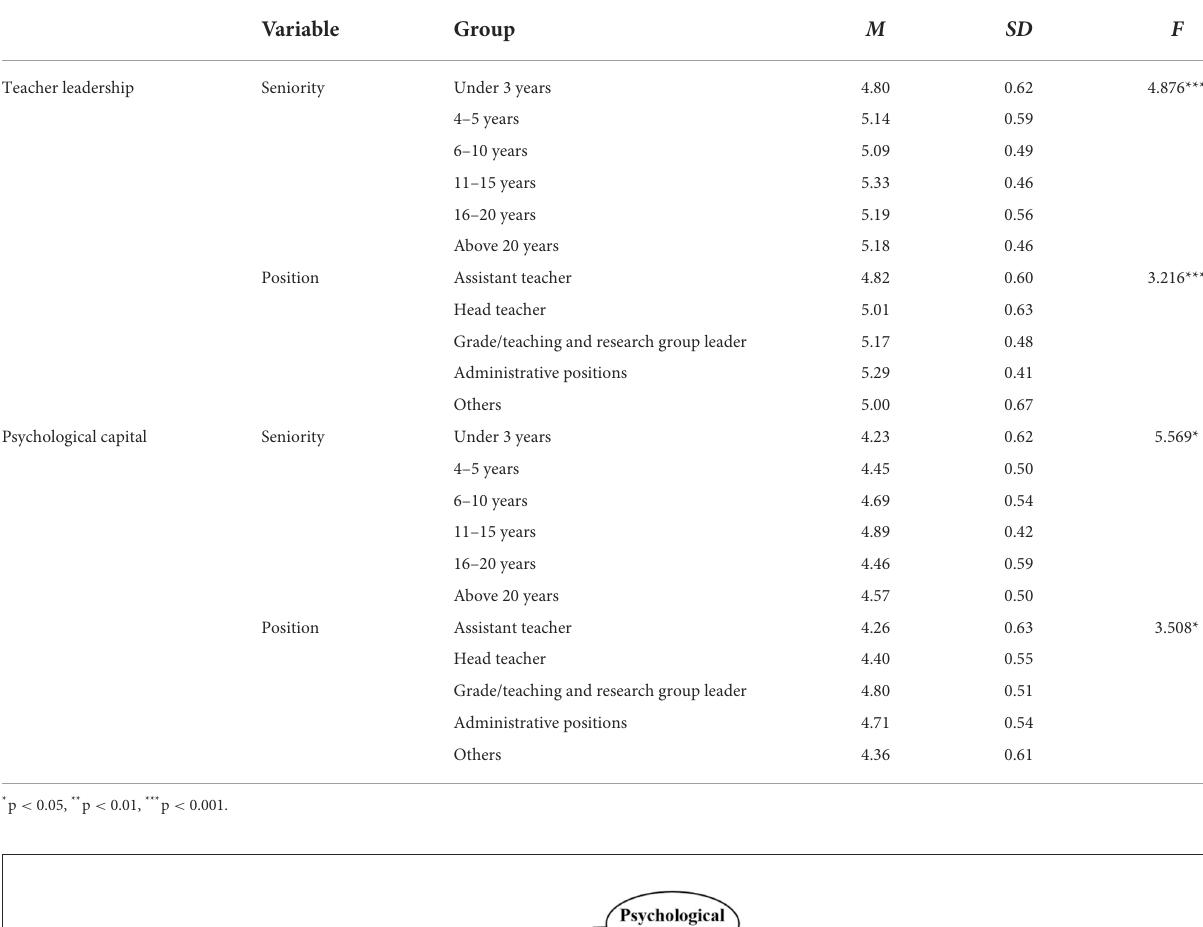
TABLE 3 Variance analysis ( N = 294).